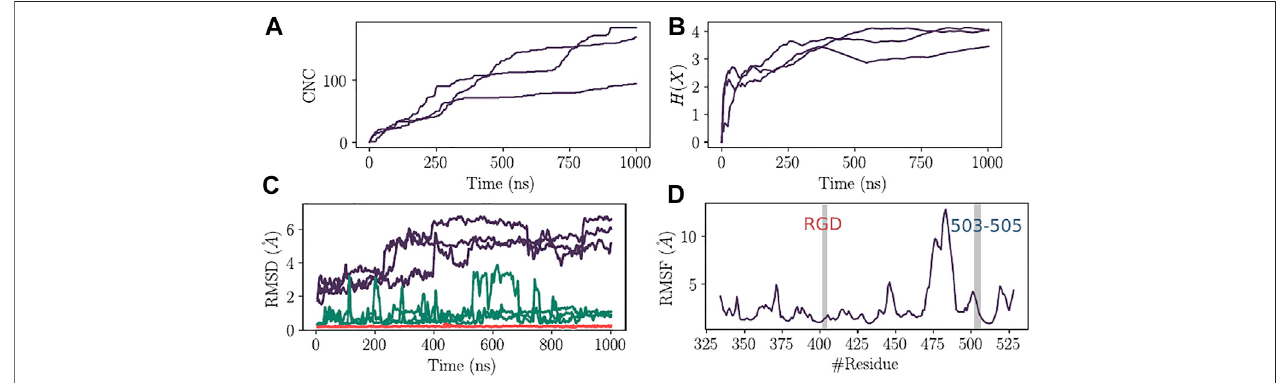
FIGURE 2 | Convergence analysis of aMD and structural deviation of RBD. (A) Cumulative number of clusters as a function of time for the three replicas of aMD trajectories. (B) EvolutionoftheShannon ’ sentropy( H ( X ))forthethreereplicasofaMDtrajectories. (C) RootMeanSquareDeviationofRBDstructure(Purple), C1cluster of residues (Green) and the RGD motif (Red). (D) Root Mean Square Fluctuation of RBD residues calculated for the C α atoms from the combined aMD